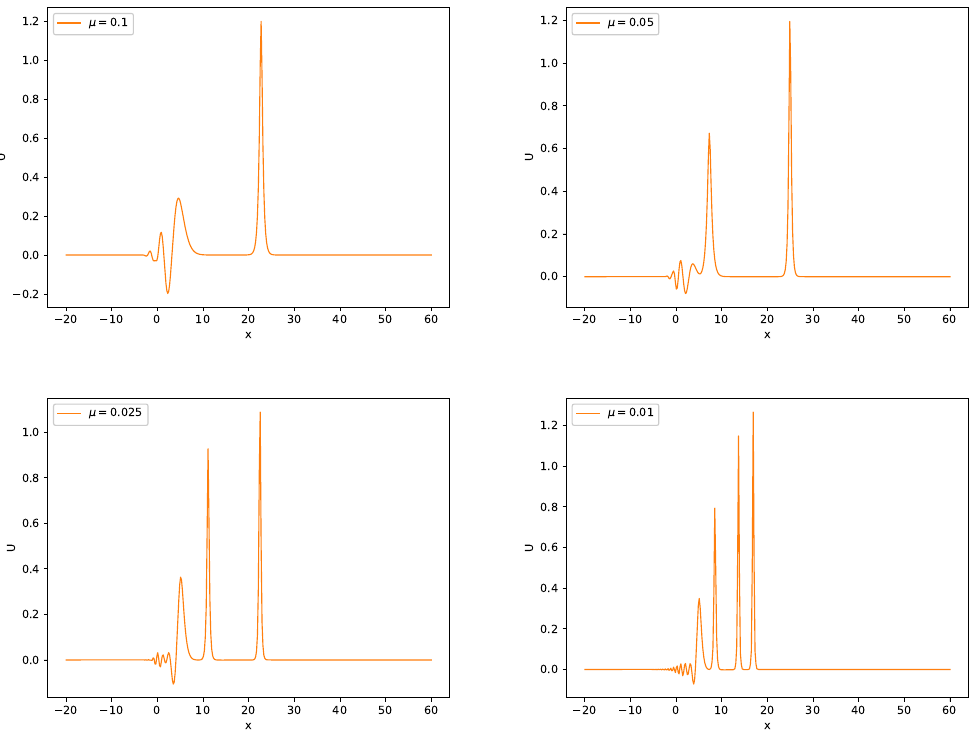
Figure 9. Numerical solution for p = 4, N = 400, ∆ t = 0 . 005 and different values of µ at t =